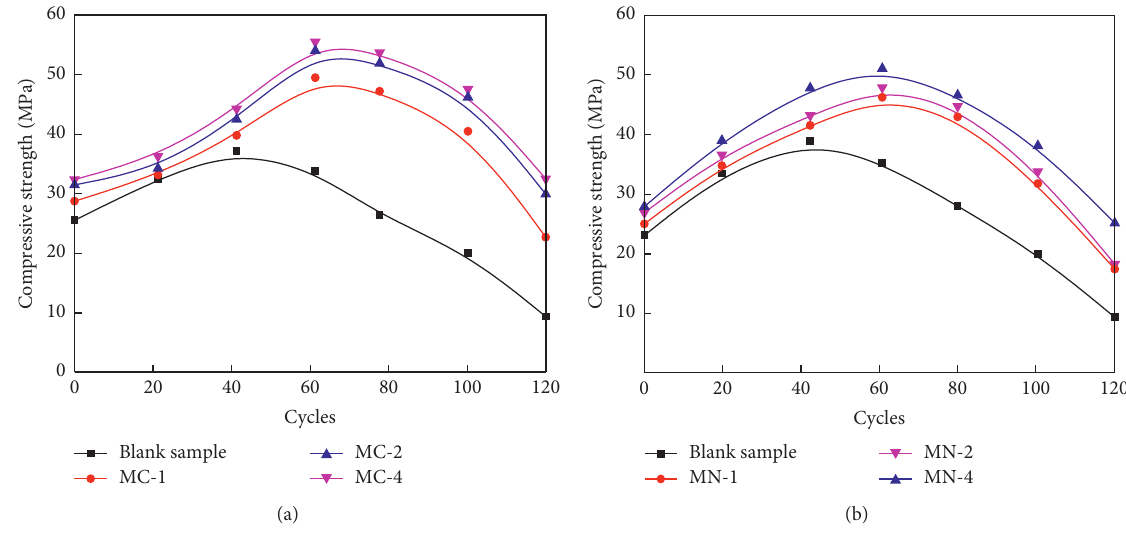
Figure 11: The compressive strength of mortar under dry-wetting cycles. (a) Mortar with N-LDH. (b) Mortar with C-LDH.